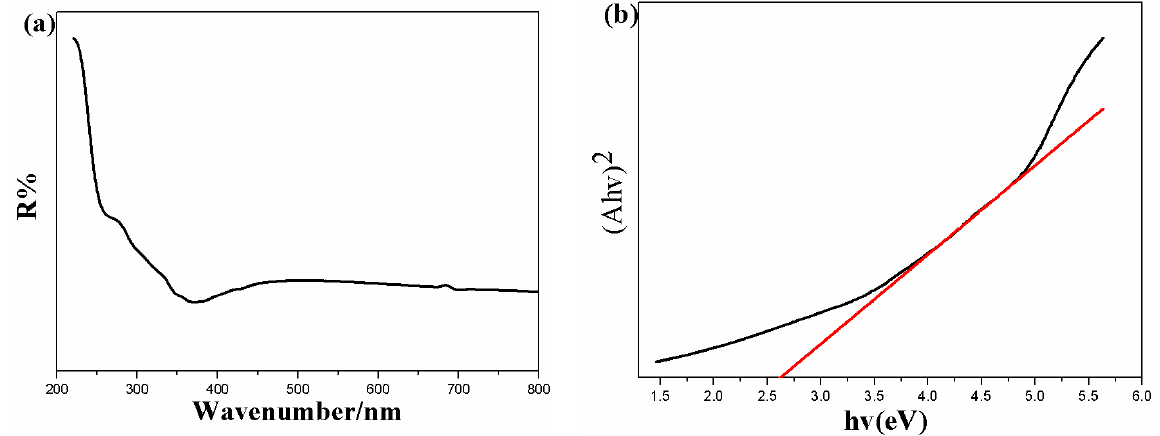
Figure 7. ( a ) UV – Vis DRS absorbance spectra and ( b ) plot of ( Ahν ) 2 versus hν for the samples. Figure 7. ( a ) UV–Vis DRS absorbance spectra and ( b ) plot of (Ah ν ) 2 versus h ν for the